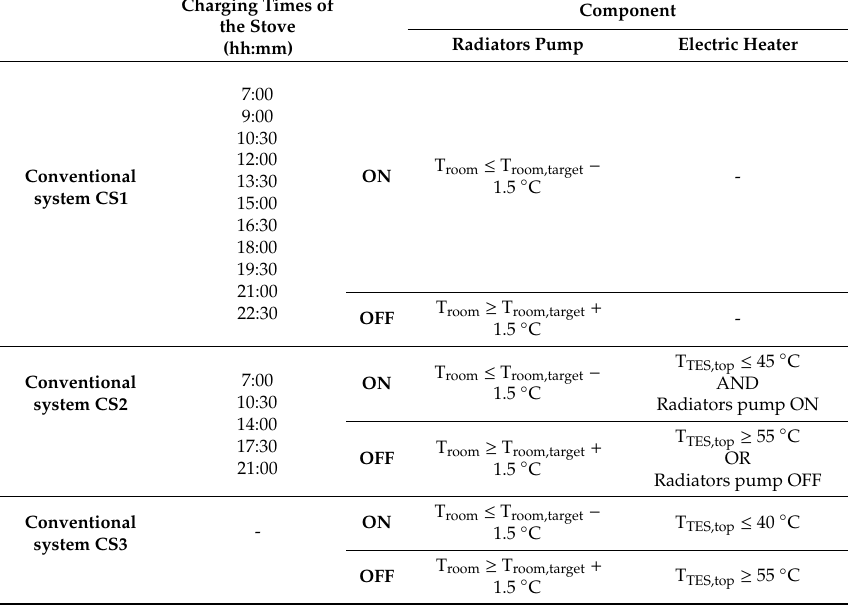
Table 7. The main control algorithms and strategies of the conventional heating systems CS1, CS2 and